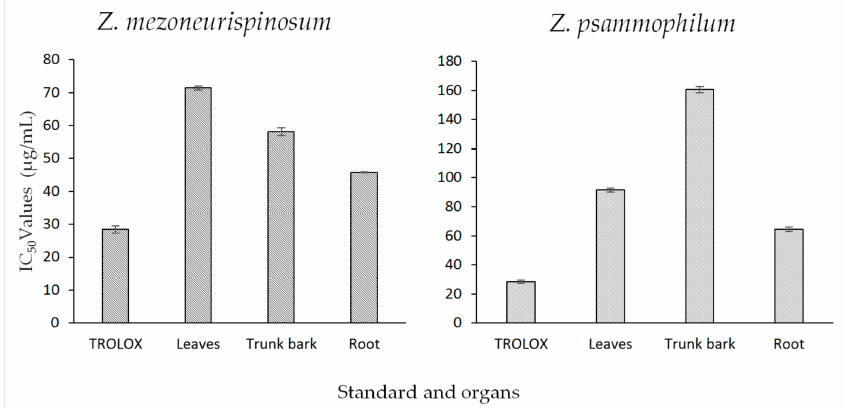
Figure 3. The IC 50 values ( µ g / mL), obtained with the 2,2-diphenyl-1-picrylhydrazyl (DPPH) assay, of essential oils isolated from di ff erent organs of Z. mezoneurispinosum ( A ) and Z. psammophilum ( B ). Data are expressed as the mean and standard value, n = 3.